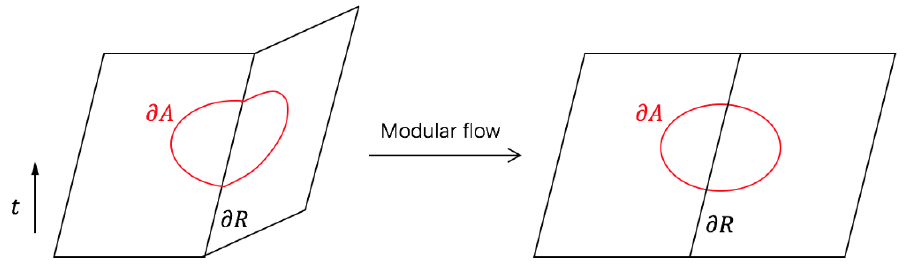
Figure 7. When @A \ @R 6 = ; , the modular (cid:13)ow can change the divergent structure. In this example, we see how the modular (cid:13)ow can get rid of the kink of a half-boosted sphere.